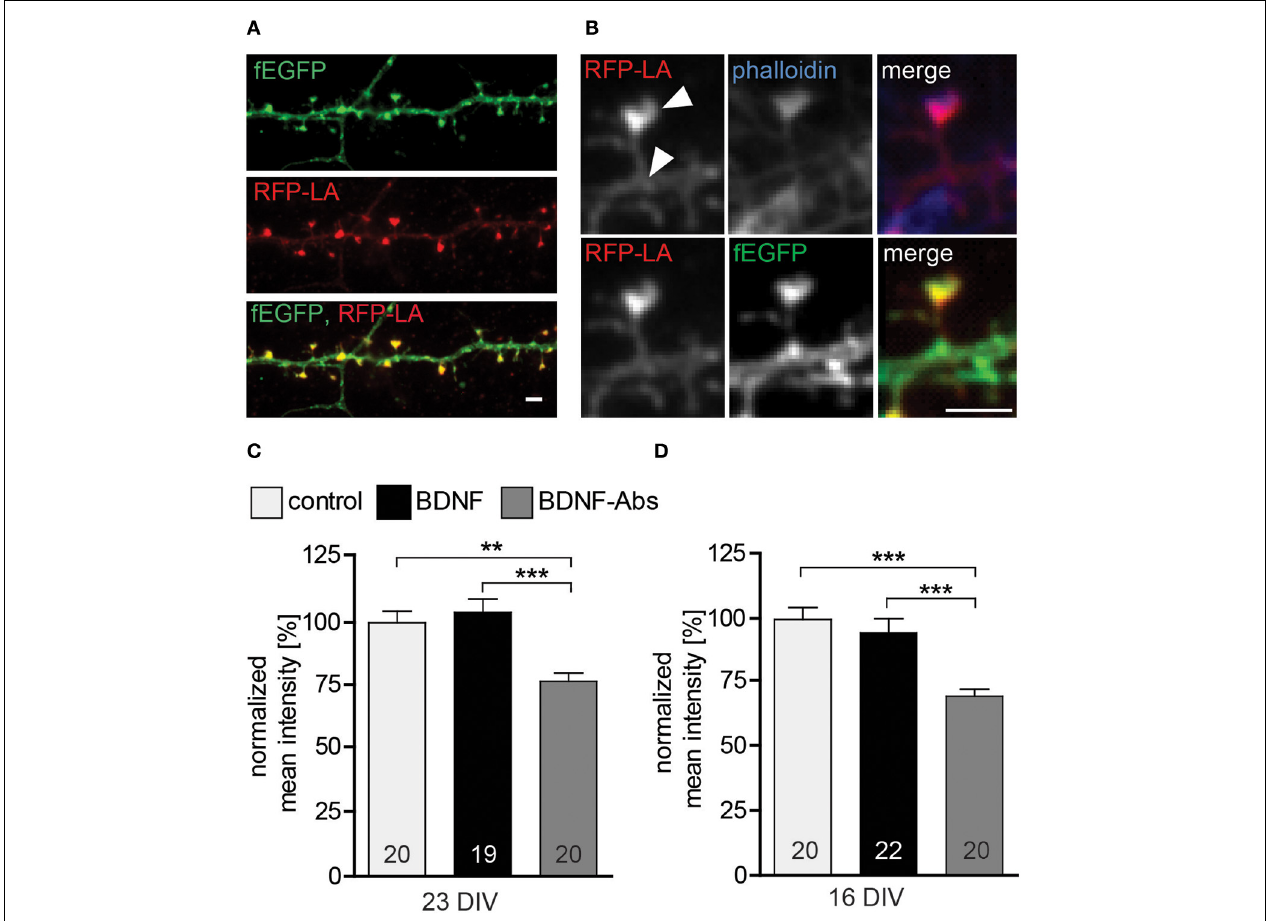
FIGURE 3 | (A) Maximalintensityprojectionof arepresentative dendrite of hippocampal neurons expressing fEGFP (above) andRFP-Lifeact (middle) merged toshow colocalization(below). Scalebar,2 μ m. (B) Highmagnification images showing asingledendritic spineexpressing fEGFP (above) and RFP-Lifeact (middle) andmerged toshow their colocalizationinthespinehead (below)Scalebar,2 μ m. (C) Histogramplottingthenormalizedmeanfluorescent